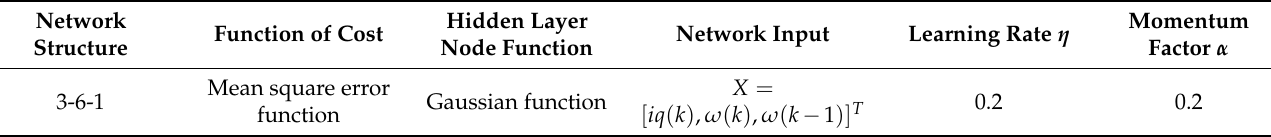
Table 1. The relevant parameters of the RBF neural